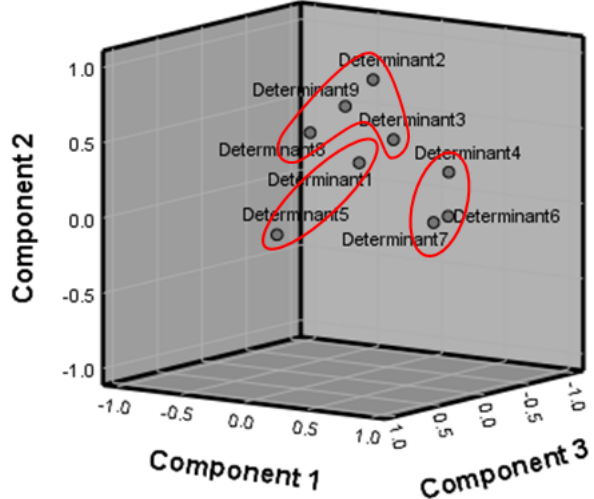
Figure 3. Component plot in rotated